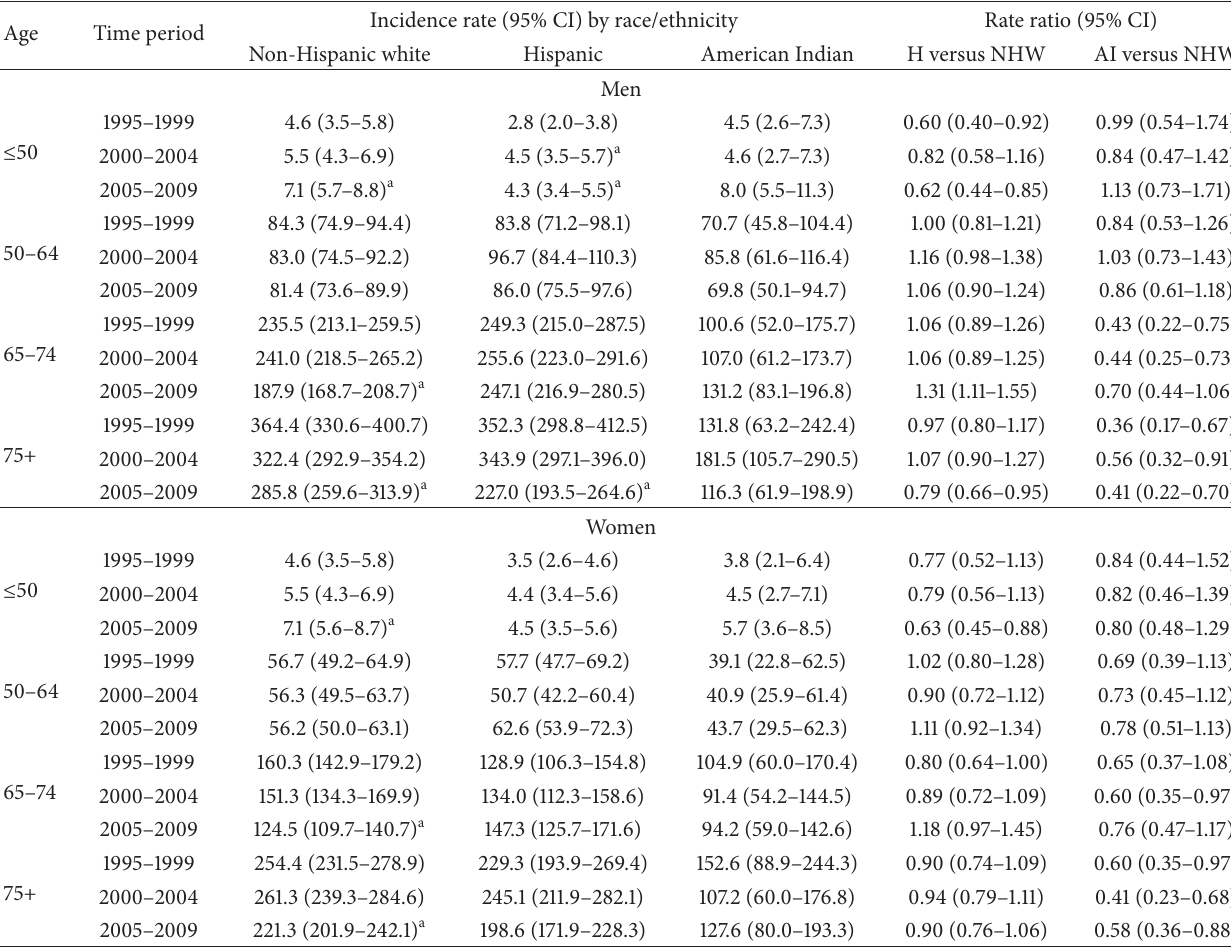
Table 1: Average age-specific colorectal cancer incidence rates by time period, race/ethnicity, and gender; New Mexico, 1995–2009. Age